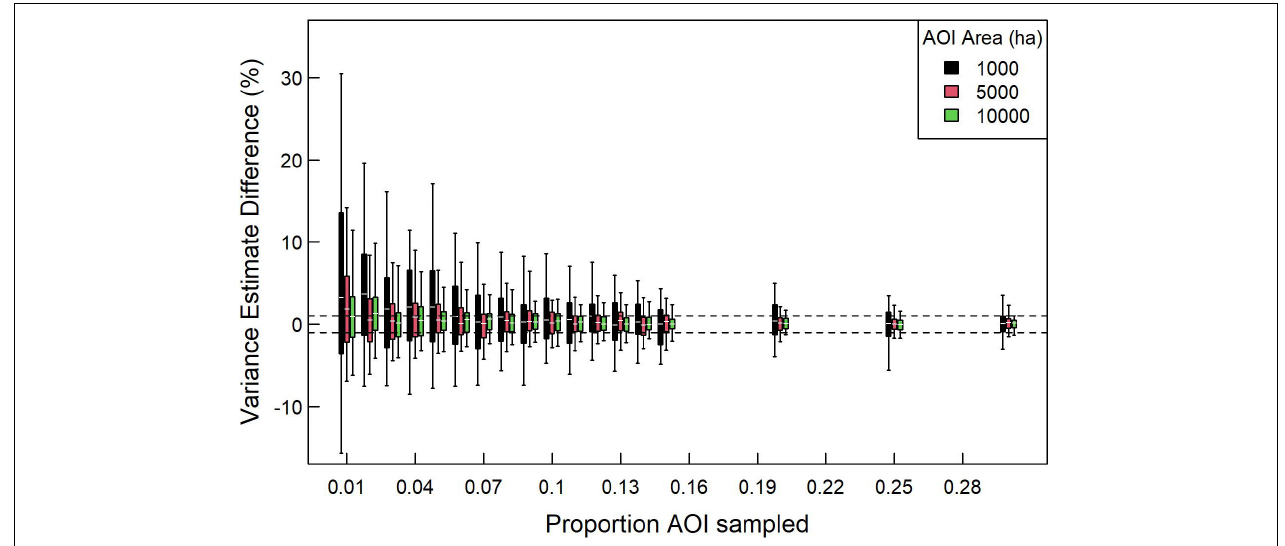
FIGURE 4 | Percent difference between AOI variance estimates based on a sample of pixels vs. using all pixels for AOIs of differing sizes. In this case, we examined 30 1,000, 2,500, and 10,000-ha AOIs distributed across the study region, each with five replicates. White horizontal lines indicate median, boxes indicate 50% intervals, and whiskers indicate 90% intervals. Dashed horizontal lines demarcate –1 and 1% differences.